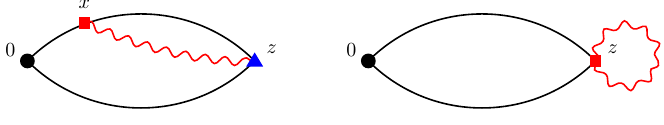
Figure 9 . The two terms from the expansion of the conserved current at the sink. Red squared vertices and blue triangle vertices refer to insertions of the conserved vector current and the tadpole operator,